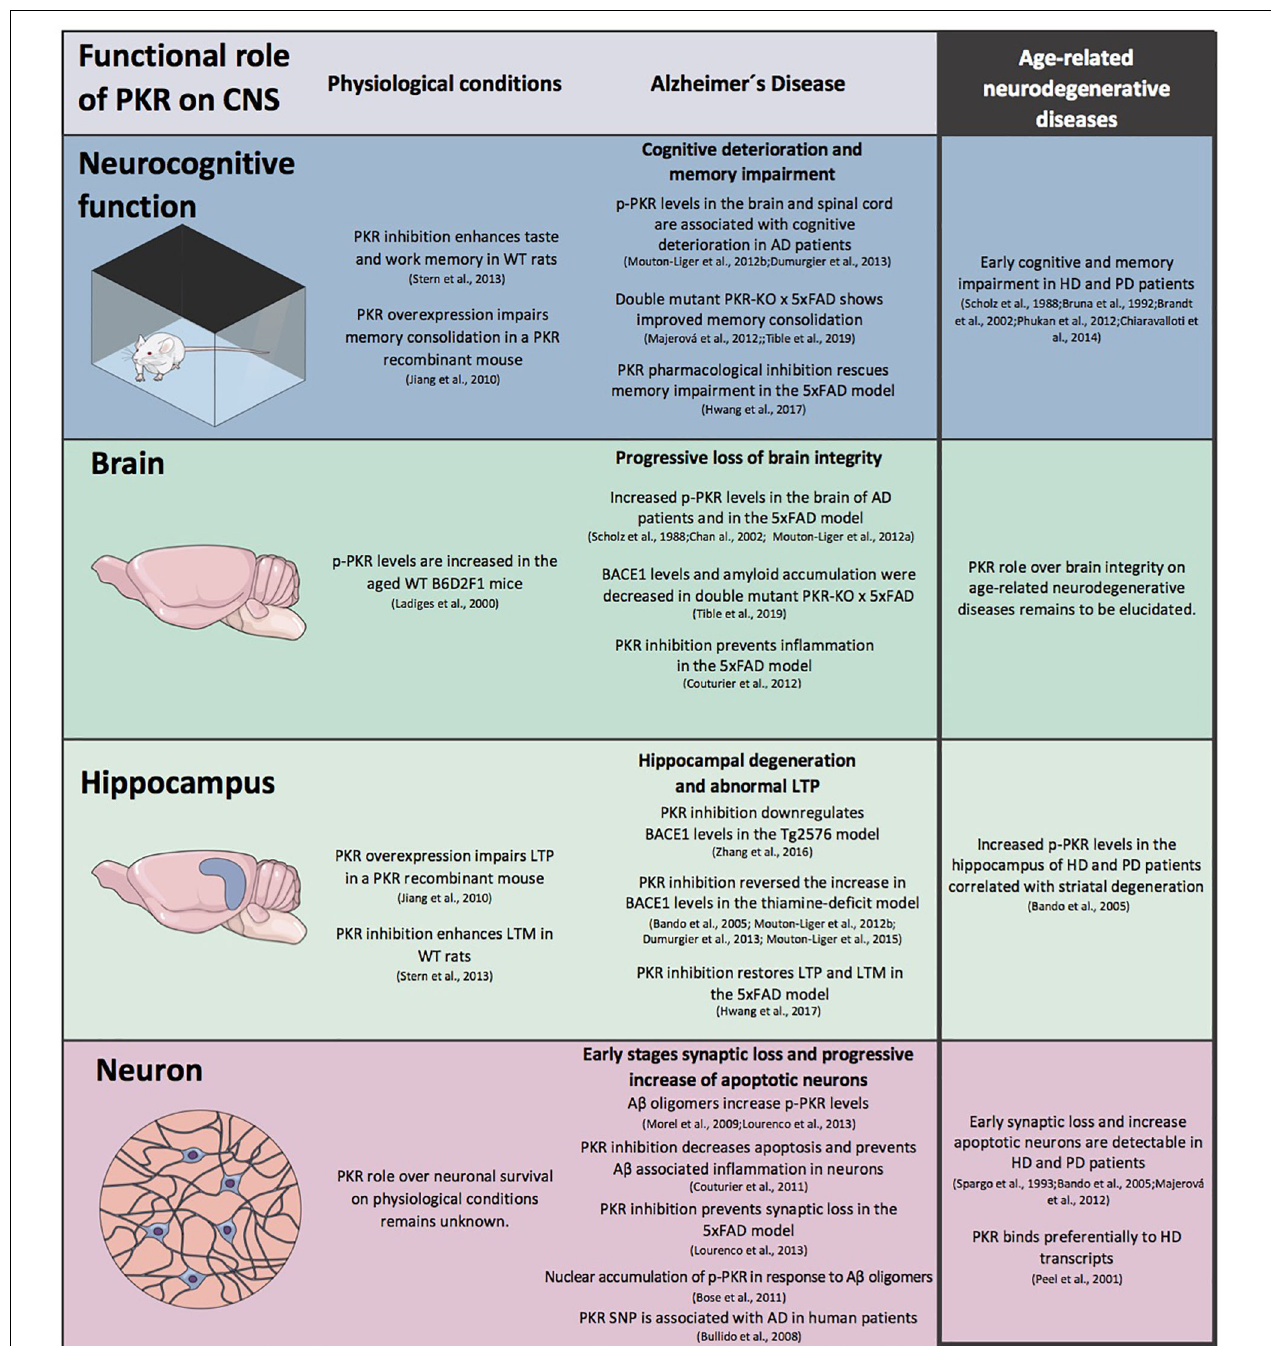
FIGURE 2 | The role of protein kinase R (PKR) in CNS physiology and pathophysiology. A schematic view of the modulation exerts by PKR in CNS morpho-functional integrity at different levels under physiological conditions and in Alzheimer’s (AD) disease. The information available for age-related neurodegenerative diseases is